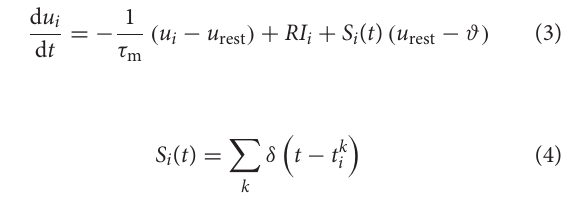
FIGURE 2 | Overview of the steps involved in generating synthetic electroencephalography (EEG) samples using the spiking neural network (SNN). The process is divided into three different stages: (1) Template extraction, where EEG template from the sample data is derived (blue box), (2) training SNN to produce EEG signal template (yellow box), and (3) activating the perturbation layers that help SNN to generate artificial samples (green